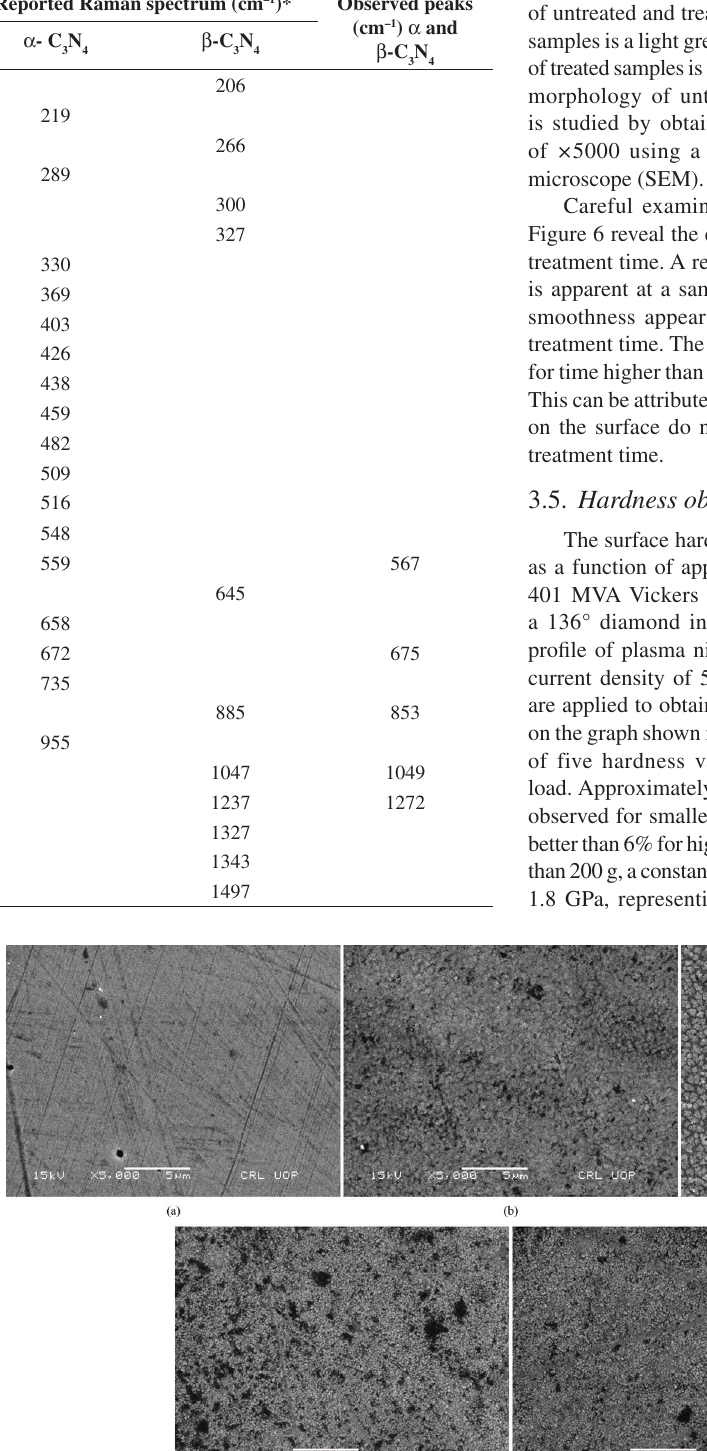
Table 4. Observed and calculated Raman frequencies in α and N . β - C 3 4 Reported Raman spectrum (cm –1 )*